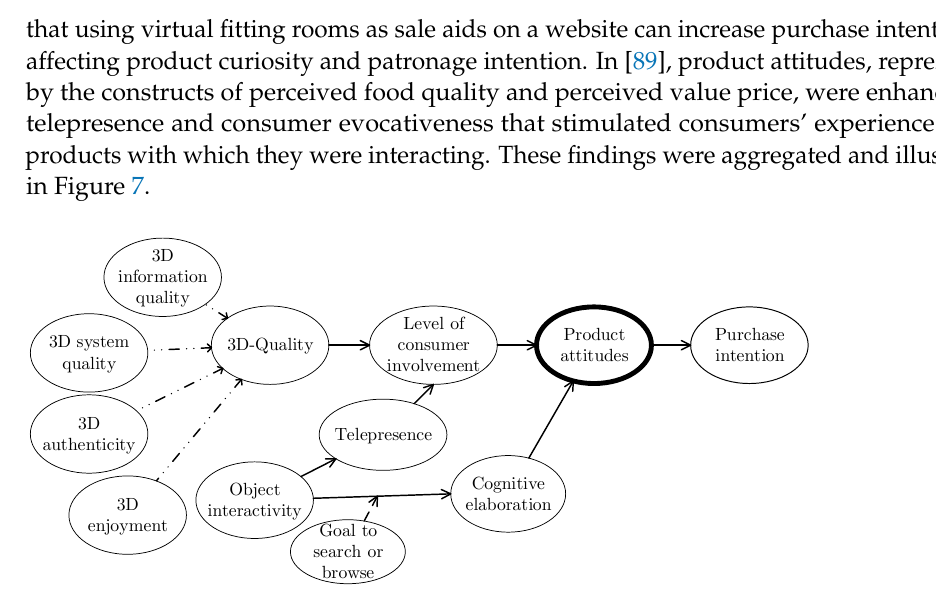
Figure 7. Conceptual framework of a consumer’s product attitudes.